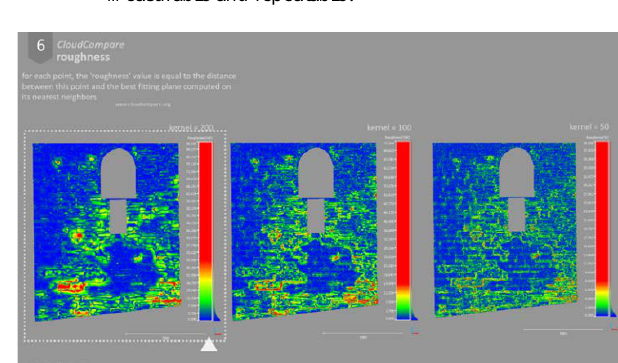
Figure 14. Mappe di rugosità al variare del valore di kernel.